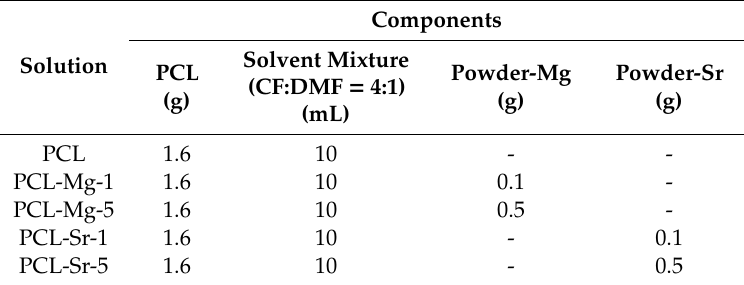
Table 2. Composition of the electrospinning